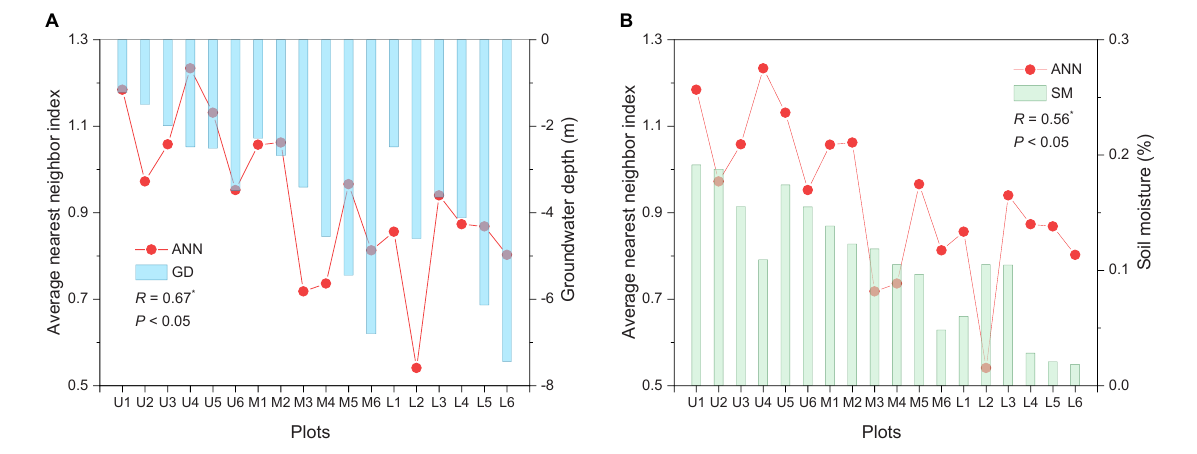
DMI t -value Distribution HSI x -value Distribution I δ t -value Distribution pattern patterns patterns patterns